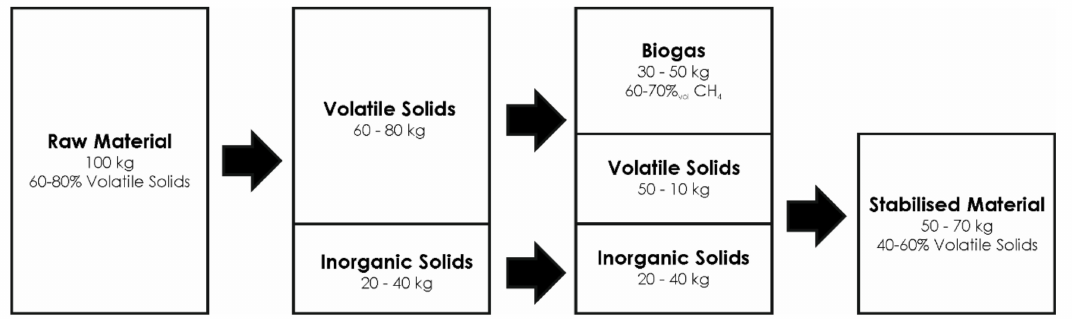
Figure 2. Volatile solids balance during anaerobic digestion.